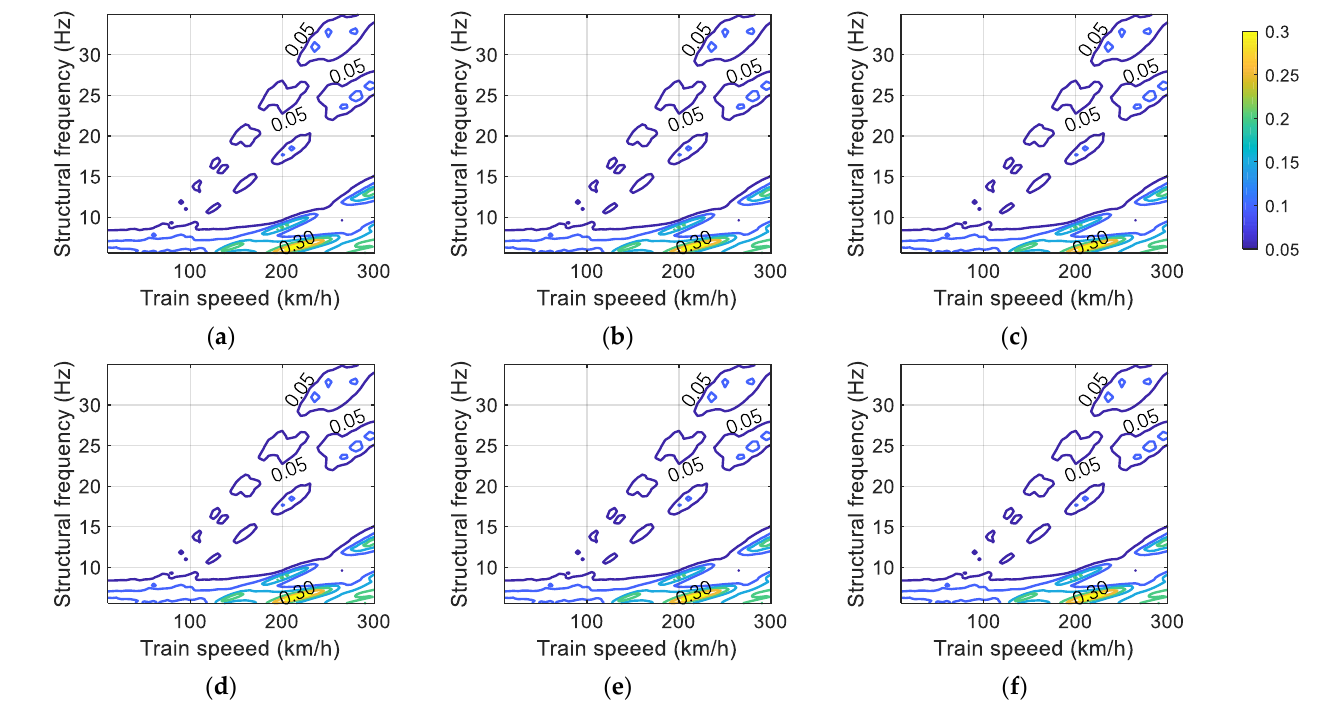
Figure 11. Radial IF of bridges under different frequencies and curved radius: ( a ) R = 400 m ; ( b ) R = 500 m; ( c ) R = 600 m; ( d ) R = 700 m; ( e ) R = 800 m; ( f ) R = 900 m.